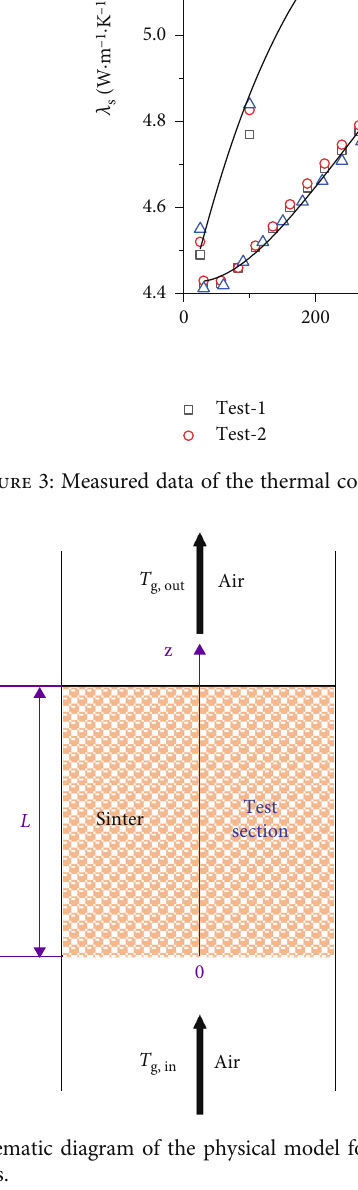
Figure 4: Schematic diagram of the physical model for the sinter cooling